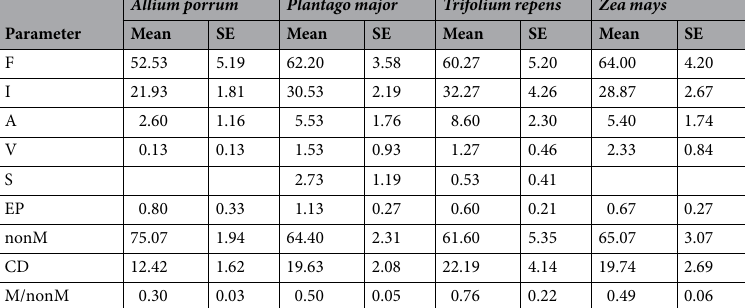
Table 2. Comparative analysis of mycorrhizal patters in 4